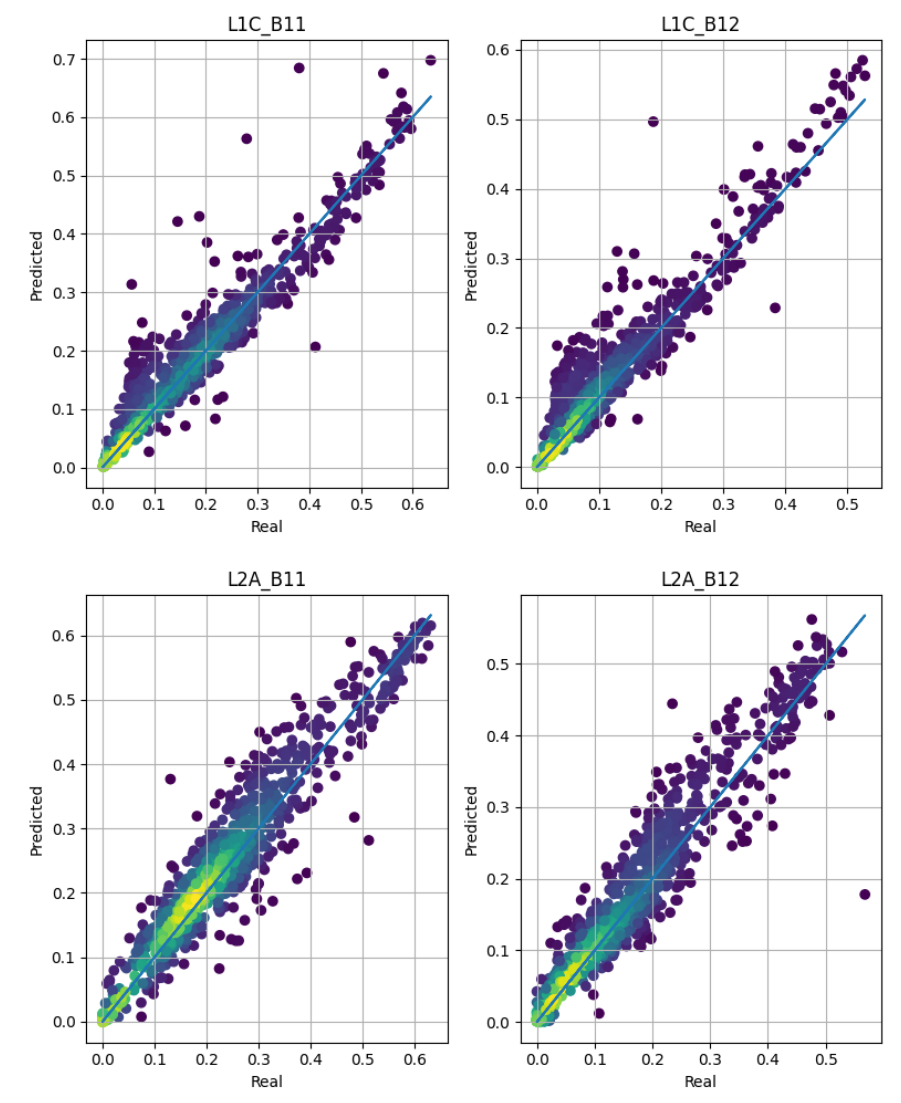
Figure 13. Scatterplots for the double-band regression of the SWIR bands in L1C ( top ) and L2A ( bottom ). The colors Figure 7. Scatterplots for the single band regression (L1C). The colors indicate the density of